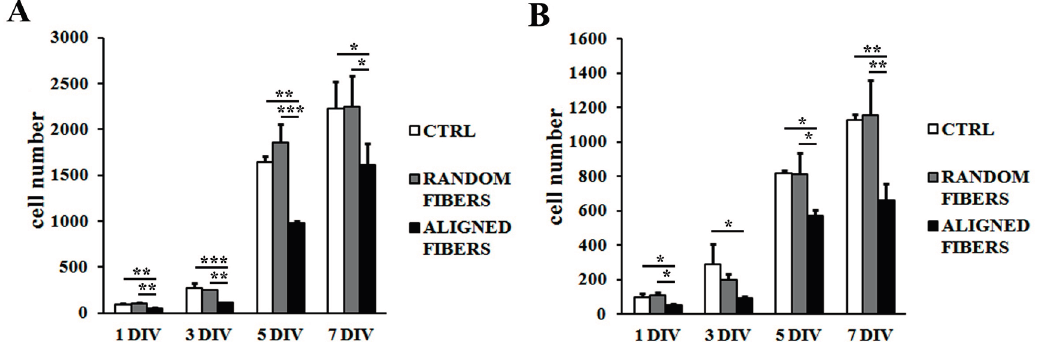
Figure 4. MTT assay: RT4-D6P2T ( A ) and primary SC ( B ) were seeded on poly- L -lysine coated coverslips (control condition), random fibers and aligned fibers. 1, 3, 5, and 7 DIV (days in vitro ) after seeding, cell viability was quantified. Asterisks refer to significant statistical difference with * p ≤ 0.05, ** p ≤ 0.01 and *** p ≤